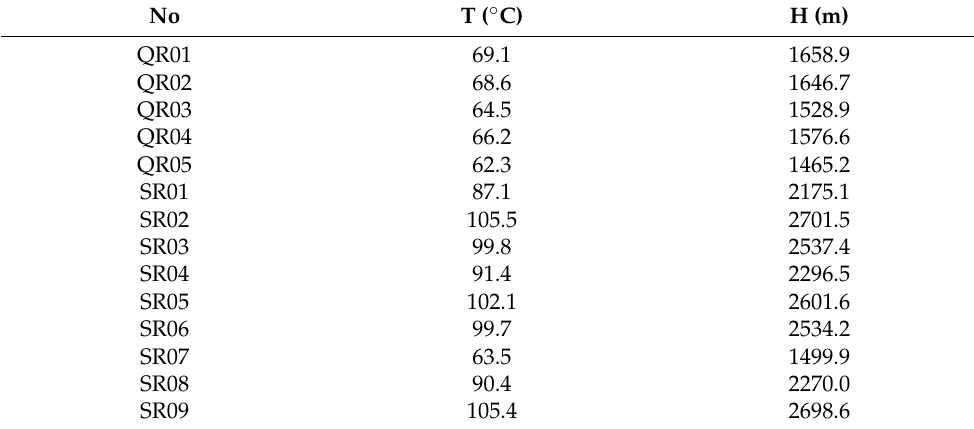
Table 6. Geothermal water circulation depth in the Rongcheng Bulge